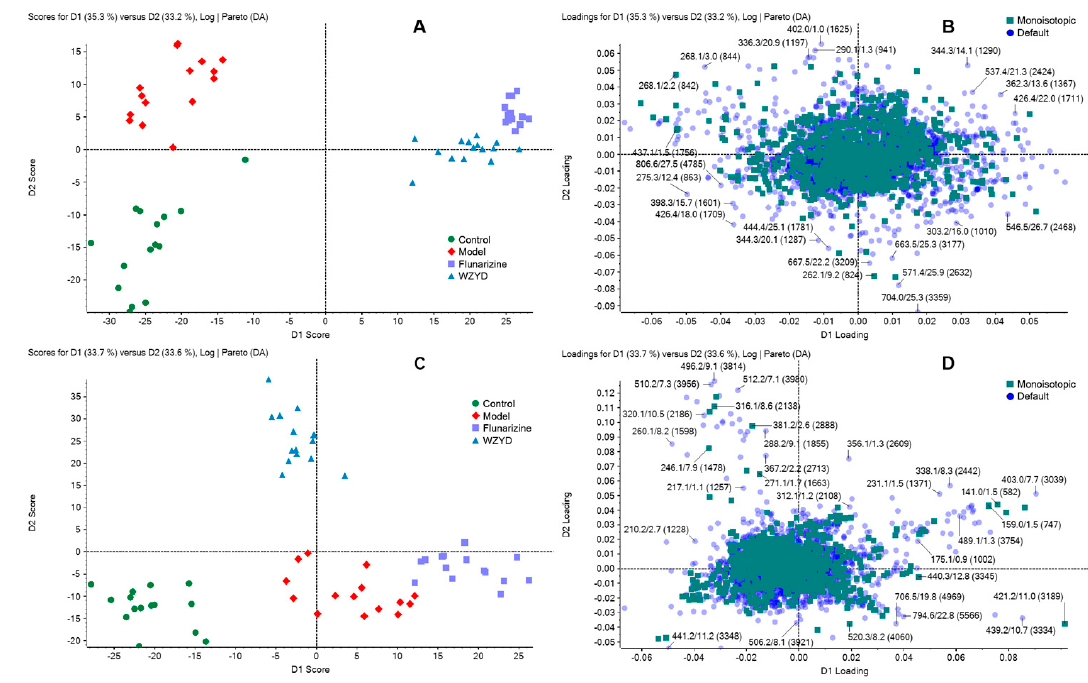
Figure 1. The principal component analysis-discriminant analysis (PCA-DA) recognition based on the brain homogenates and plasma metabolomic profiling. ( A ) Brain metabolomics score plot of control group (green), model group (red), Wu-Zhu-Yu decoction (WZYD) group (blue) and flunarizine group (purple); ( B ) Loading plot, each dot represents a compound which contributed in group separation; ( C ) Plasma metabolomics score plot; ( D ) Plasma metabolomics loading plot.